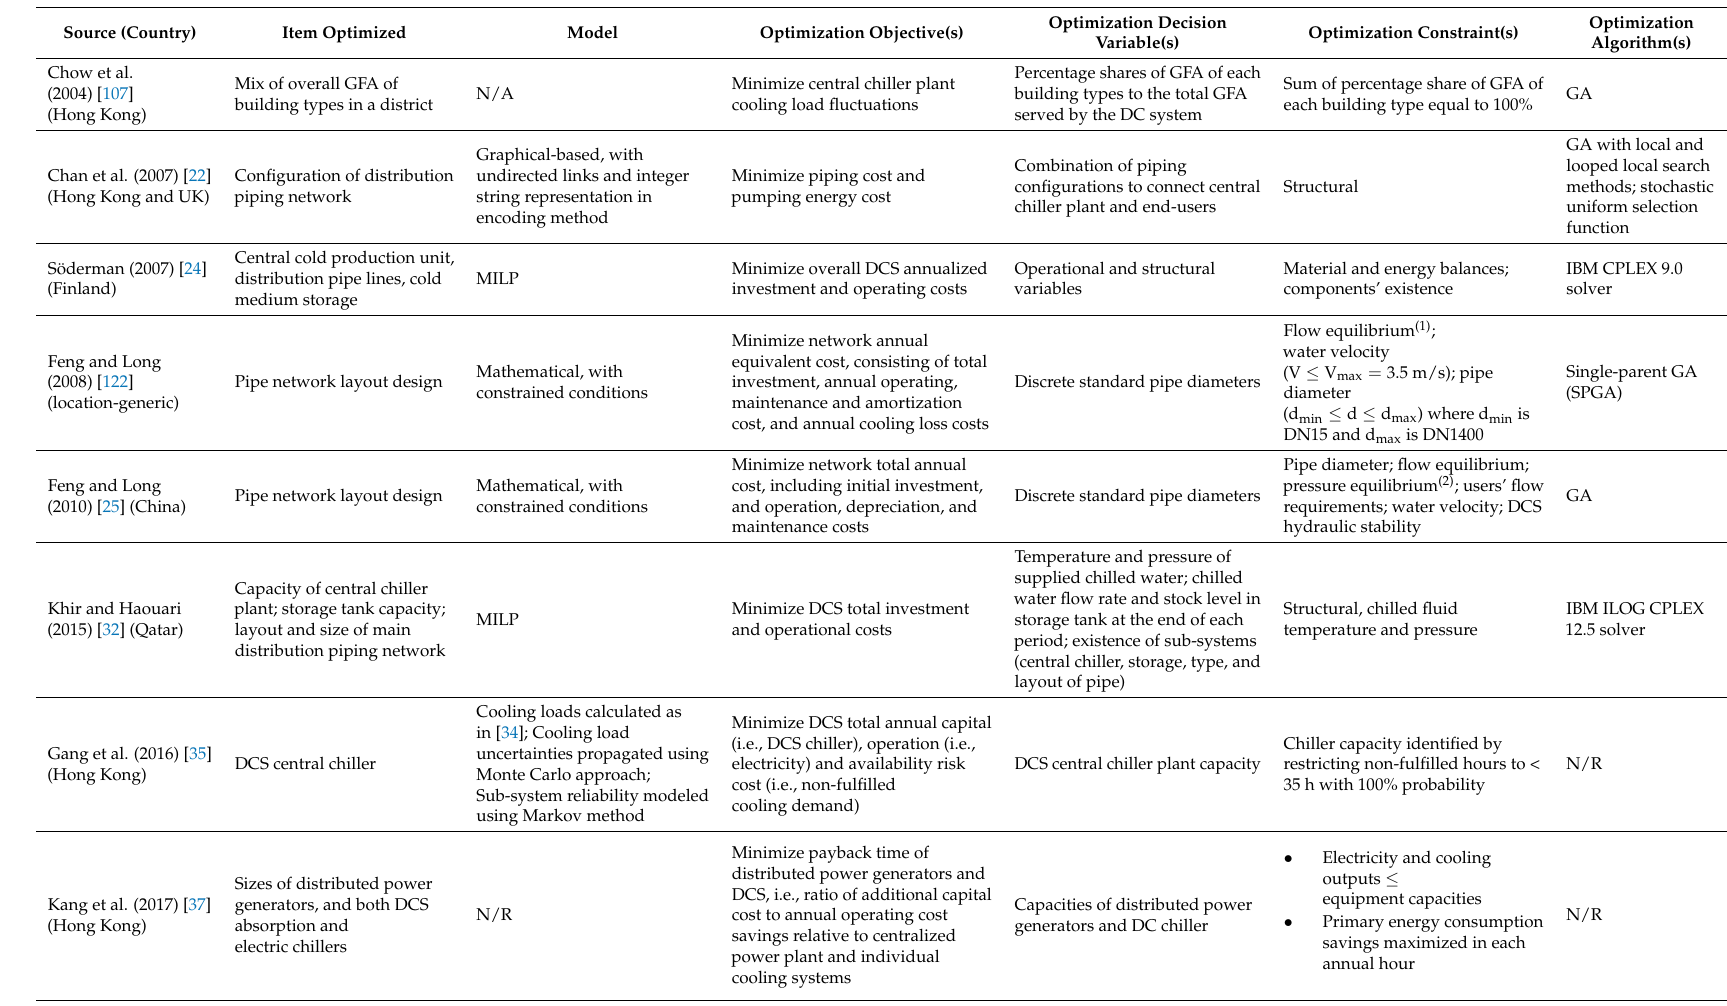
Table 4. Overview of DC system optimization